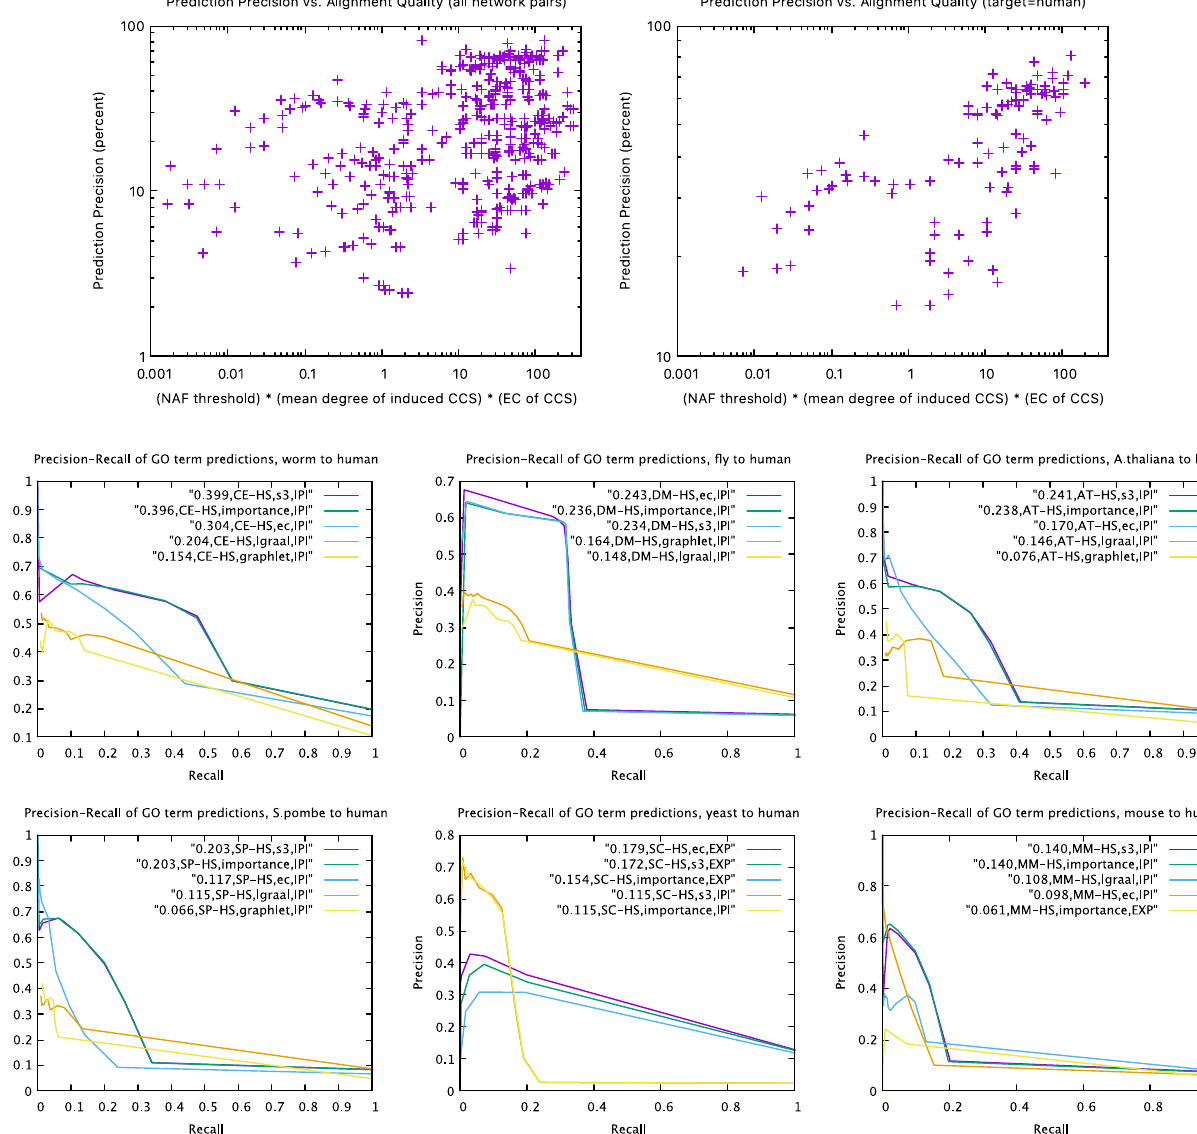
Fig. 4 TOP (purple scatter plots): Mean precision of GO term predictions vs . alignment quality between all species pairs (left, Pearson ρ = 0.19, p = 0.002, n = 511) and species pairs when human was the target (right, Pearson ρ = 0.61, p = 2 × 10 − 11 , n = 107). In both cases, alignment quality is measured as the product of NAF, EC, and mean degree of aligned nodes induced on the CCS with the given NAF. Predictions were made using only BioGRID networks and GO terms available as of April 2010, and validated against GO terms available a decade later (April 2020). Bottom: Precision-Recall of 2010-based NAF predictions of GO annotations for human proteins: Predictions are made using only data available as of April 2010, validated against the GO release of April 2020. We omit any predictions in which the aligned proteins had any known orthology or detectable sequence similarity. We plot precision vs. recall of predictions from global network alignments between the network pairs where human is the target and which satisfy the degree-3 criterion, which are (left to right, top to bottom) C. elegans, D. melanogaster, A. thaliana, S. pombe, S. cerevisiae , and M. musculus ; the six fi gures are ordered by species from best-to- worst by the mean AUPR of each fi gure. Within each fi gure, the legends are ordered best-to-wost by AUPR, and labeled by: AUPR, species pair, measure of topological similarity, and predicting evidence code (i.e., the evidence code of the non-human protein used to source the prediction for the aligned human protein). Precision is the number of correct predictions as a fraction of all predictions arising at the threshold NAF, and the denominator of Recall is the cardinality of the set resulting from the intersection of the following two sets: Predictable in principle pairs, and the annotations actually present in the April 2020 GO release (called the validating set — see “ Methods ” ). See Table 4 for F - NAF and Resnik using either GO terms of all evidence codes (middle We move now to the tables below the postage stamps of Fig. 2. section) or excluding any GO terms with sequence-based evidence, The top table lists the Pearson correlations and statistical even if they also have non-sequence evidence (right section). In signi fi cance of the plots. For the species pairs mouse-human each section we list the Pearson correlation ρ , the p -value computed ( “ MM-HS ” , top two rows) and yeast-human ( “ SC-HS ” , bottom two using Fisher ’ s r -to- z transformation, as well as the number of rows), we list the number of aligned protein pairs ( “ #aligs ” ) with NAF standard deviations ( σ ’ s) from random represented by that p -value. score 2% or more, and compute the Pearson correlation between